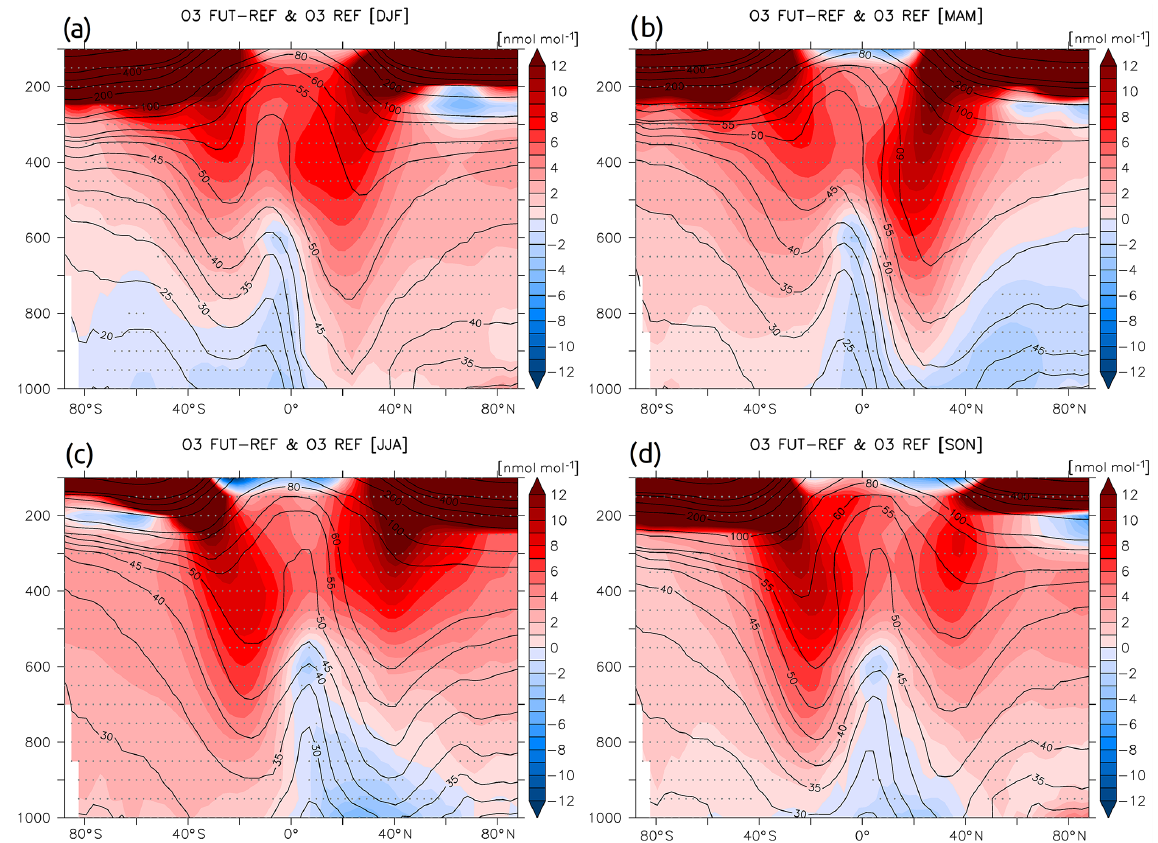
Figure 5. Differences of zonal-mean ozone concentrations between the FUT and REF periods (shaded; nmolmol − 1 ) for DJF (a) , MAM (b) , JJA (c) , and SON (d) . The black contours denote the zonal-mean ozone concentrations (nmolmol − 1 ) during the REF period. Grey dots denote statistically significant changes at the 99% confidence